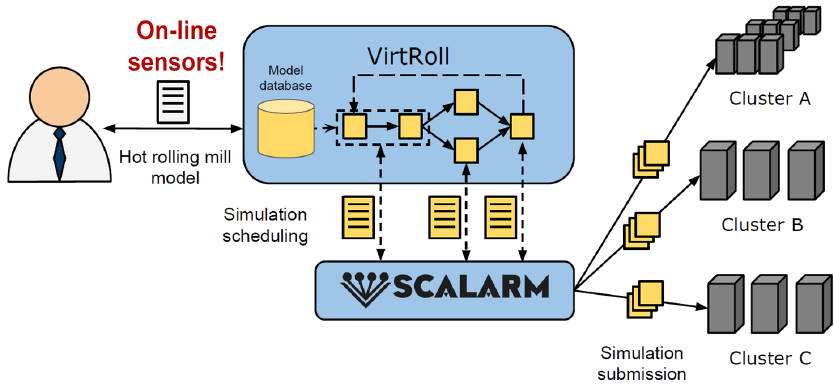
Figure 13. Architecture of the VirtRoll system integrated with on-line